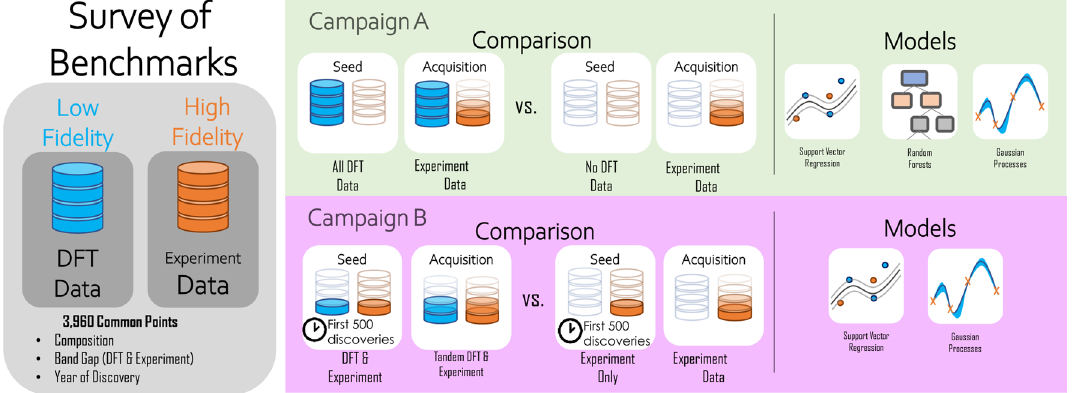
Figure 4. Campaigns performed for single-fidelity acquisition and multi-fidelity acquisition. In campaign A, we compare the results of including all or no DFT data in the seed data set and only acquire experimental data. This campaign effectively compares an “a priori” agents to a single-fidelity agents. In campaign B, the multi-fidelity agents are seeded with first 500 experimentally discovered compositions (based on ICSD 58 timeline of their first publication 59 ) and their corresponding DFT data. Both DFT and experimental data are acquired here. The single-fidelity agents are exclusively seeded with and acquire experimental